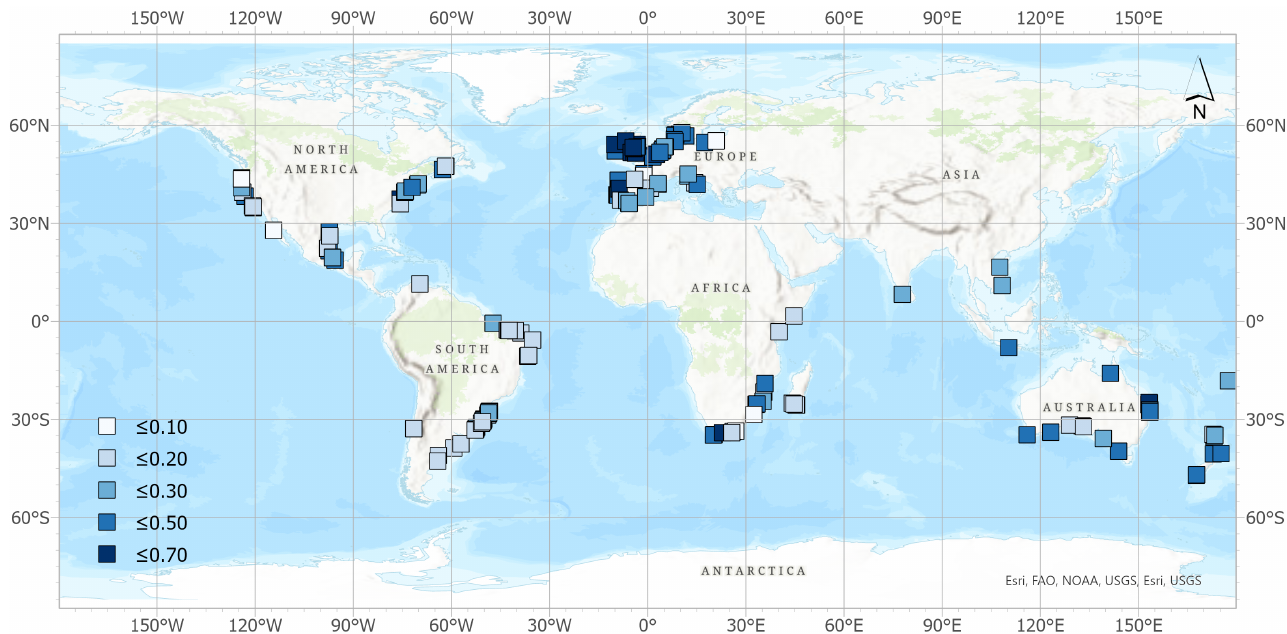
Figure 7. Temporal (1984–2021) mean of the trend component in NDVI. The intersite variability in greening was also compared with the strength of the seasonal component in NDVI, denoted here as ∆ NDVI and calculated as the range between the 10th and 90th percentile of the zero-mean seasonal component Se. A joint visual inspection of the maps of ∆ NDVI (Figure 8) and greening (Figure 4) revealed that greening also took place irrespective of the strength of the seasonal NDVI. The largest ∆ NDVI’s were found in dune fields in cool to warm moist conditions, most notably in Northwestern Europe and on the East coast of the US (Figure 8). In Northwestern Europe, ∆ NDVI varied between 0.103 at Anholt Island in Denmark and 0.298 at Brownslade Burrows in Wales. The lowest ∆ NDVI value in our data set was reached for the dry conditions of Guerrero Negro, Mexico (=0.009), and the maximum value was 0.345 for the Greenwich dunes in Canada with cool temperate moist conditions. As expected, ∆ NDVI depended on